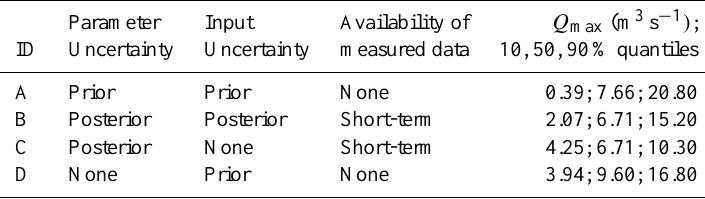
Table 3. Predictive performance for different scenario analysis for the maximum peak flow. Q max observed was 2.9m 3 s − 1